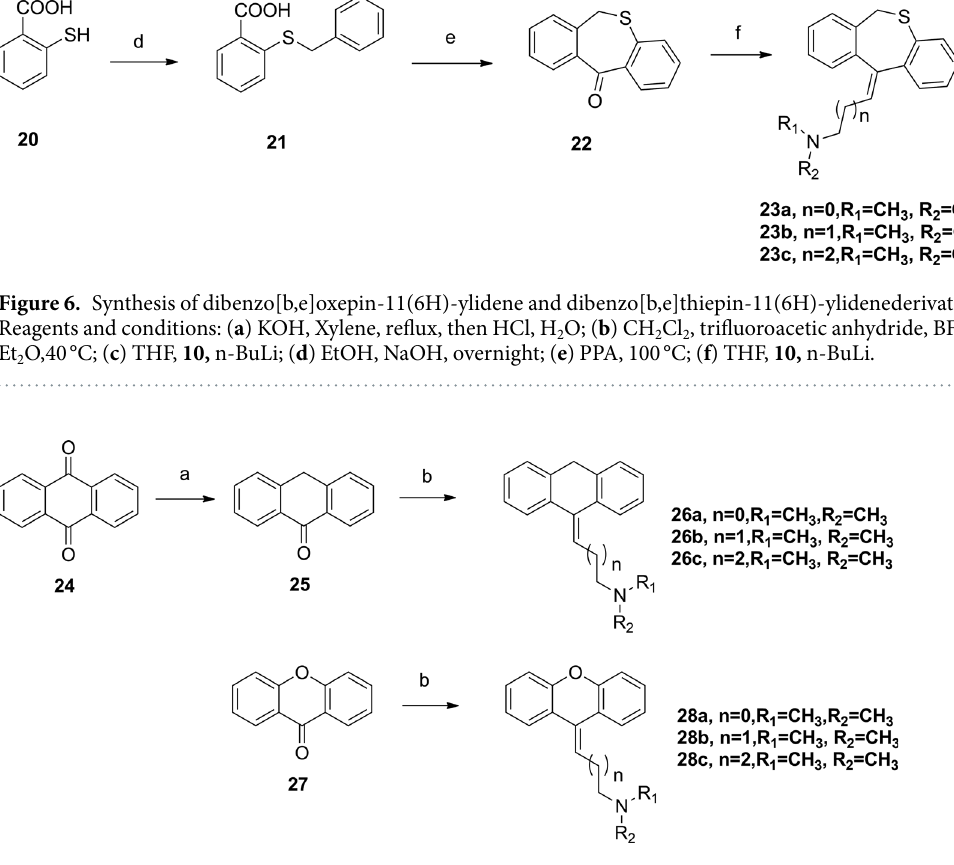
annulen-5-ylidene core through a different length linker were synthesized to improve the molecular flexibil- ity. Disappointingly, these compounds demonstrated negligible effects on PARP1 inhibition comparing with compound PA-10 (Table 2). Further, switch of the terminal N substituents to phenyl, afforded new derivatives 15a–e, showing less improvement in PARP1 activity (Table 3). Therefore, the structural modification of side chain exhibited when n = 1, R1 = R2 = Me, it had best activity. To further explore the impact of core structure, a series of bioisostere was synthesized, compound 19 and 23 was obtained through ibenzo[b,e]oxepin-11(6H)-one ( 18 ) and dibenzo[b,e]thiepin-11(6H)-one ( 22 ). Interestingly, both compounds displayed significantly enhanced PARP1 activity and anti-proliferative activity (Table 4), especially compound 19b , showing an IC 50 value of 0.75 μ M. However, replacing the core structure to anthracen-9(10H)-ylidene or 9H-xanthen- 9-ylidene, led to compounds 26a–c and 28a–c, possessing almost no PARP1 inhibitory activity (Table 5). From further analysis of co-crystallization and pharmacophore, we assumed that 2-substituted groups might be an important functional group interacting with PARP1 protein. Therefore, a series of 2-substituted 3-(dimethylamino)propylidene)-6,1 1-dihydrodibenzo[b,e]oxepin derivatives were obtained from compound 31 . Lots of new compounds displayed significantly enhanced PARP1 activity, especially compound 33e (hereafter refer to OL-1), showing an IC 50 value of 0.079 μ M against PARP1 and 0.736 μ M against MDA-MB-436 cells (Table 6) and being 10-fold more potent than leading compound PA-10, while the one of the positive control Olaparib showing an IC 50 value of 0.005 μ M